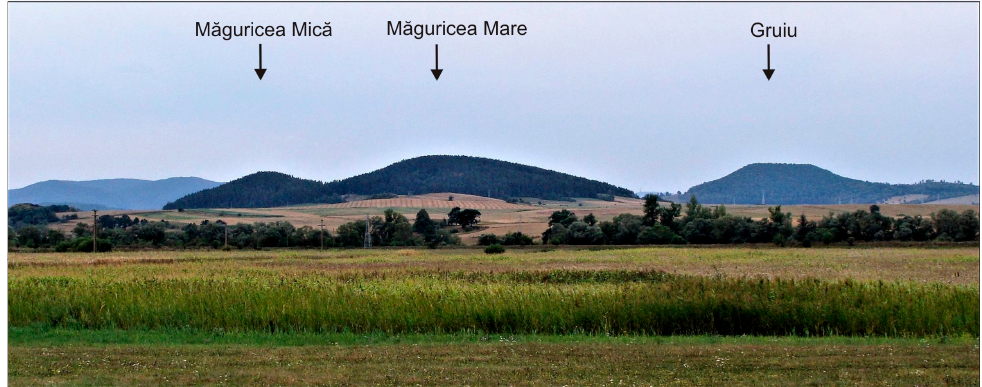
Figure 14. Positive landforms in the Per ș ani Mountains alkali basaltic volcanic field: scoria cones of different ages, from left to right: M ă guricea Mic ă , M ă guricea Mare and Gruiu. Note their different morphological profiles, reflecting different degrees of erosional modification: Gruiu is the youngest (ca. 0.6 Ma) of them. (Photo: Alexandru Szakács).